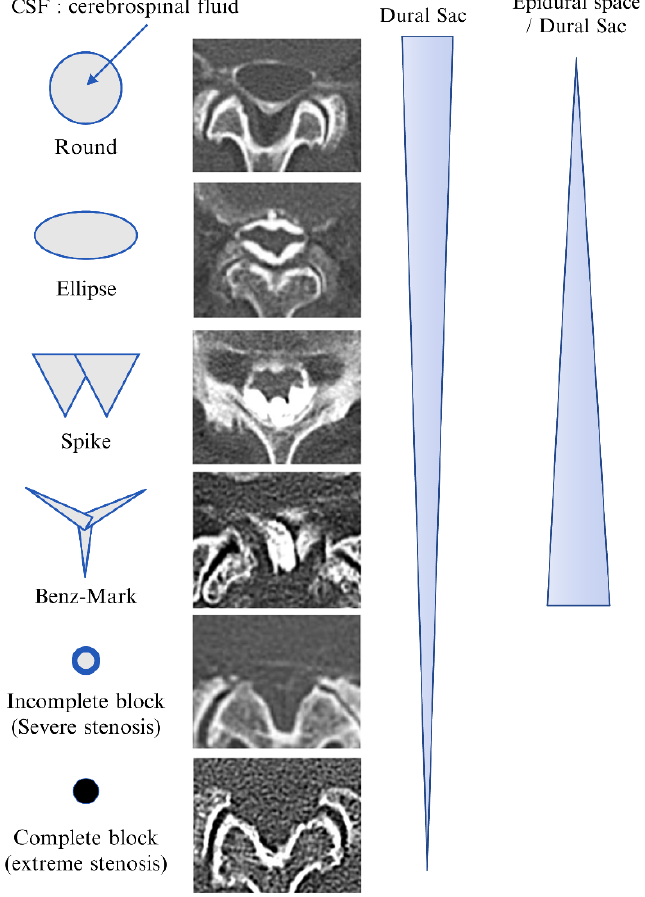
Figure 1. Classification of computed tomography epidurography. CSF, cerebrospinal fluid.